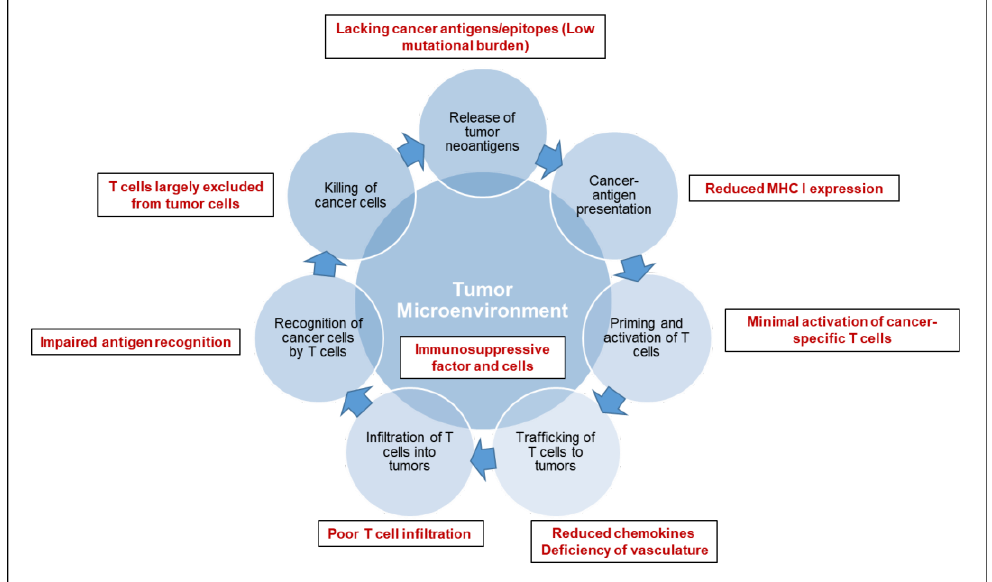
Figure 1. Deficiencies in the tumor microenvironment of pancreatic cancer. The mechanistic processes of anti-tumor immune response are delineated in the diagram. The deficiencies in tumor microenvironment that lead to the failure of anti-tumor immune response are highlighted in red.